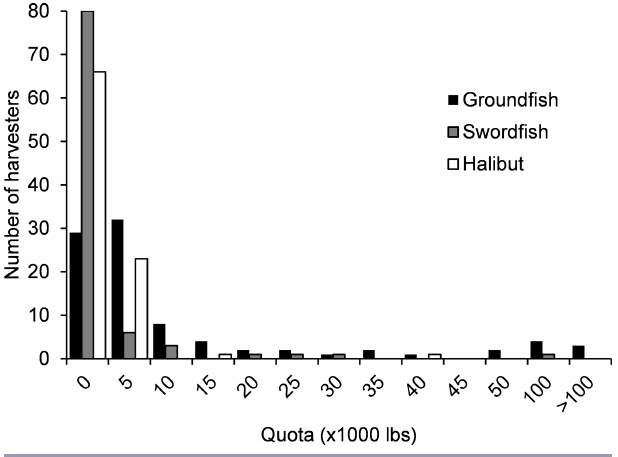
Fig. 2 . Histogram of quota ownership for groundfish, swordfish ( Xiphias gladius ), and halibut ( Hippoglossus hippoglossus ) among fishing captains in Barrington